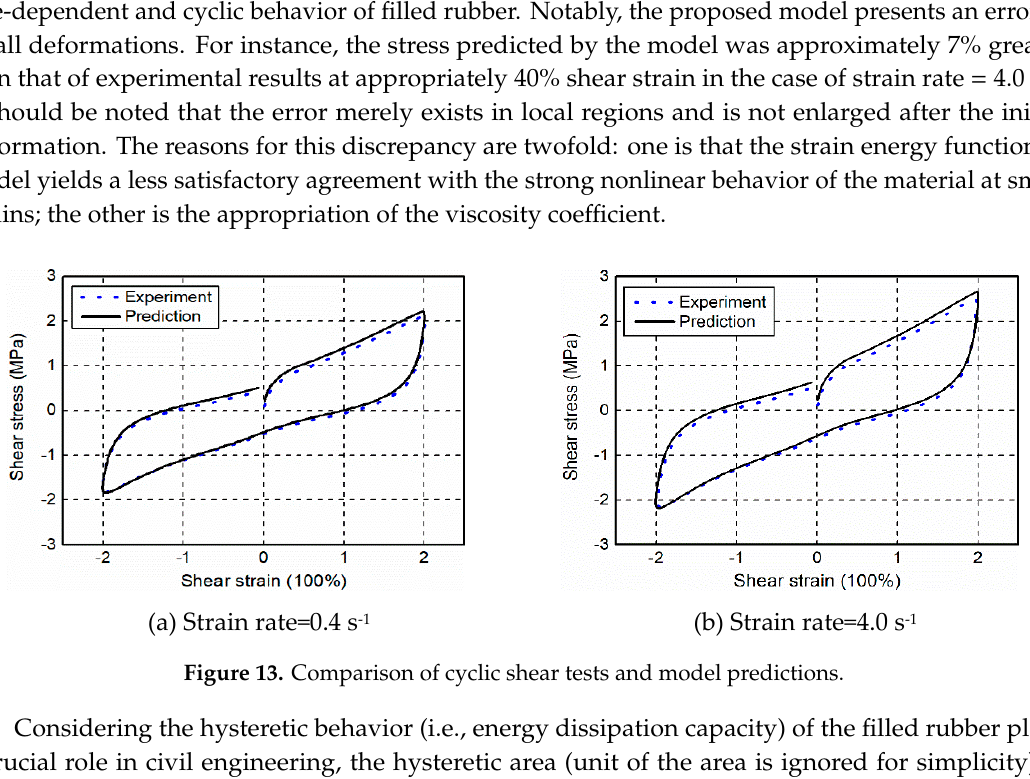
Figure 12. Comparison of monotonic shear tests and model predictions.